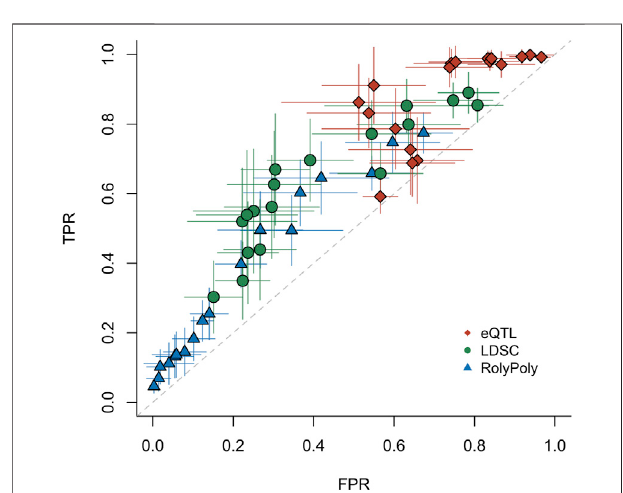
FIGURE2| ROCforthreedistinctmethods.Fortherealdataapplication testing 27 traits v.s. 44 tissues, we estimated the operating characteristics of each method (eQTL, LDSC,and RolyPoly). Eachpointrepresentsthemeanof 99 bootstrap estimates. The whiskers give the standard errors of TPRs and FPRs based on the bootstrap estimates. Each point wasevaluated under a particular p -value threshold: 0.01, 0.02, ... , 0.09, 0.1, 0.2, ... , 0.9. TPR: true positive rate. FPR: false positive